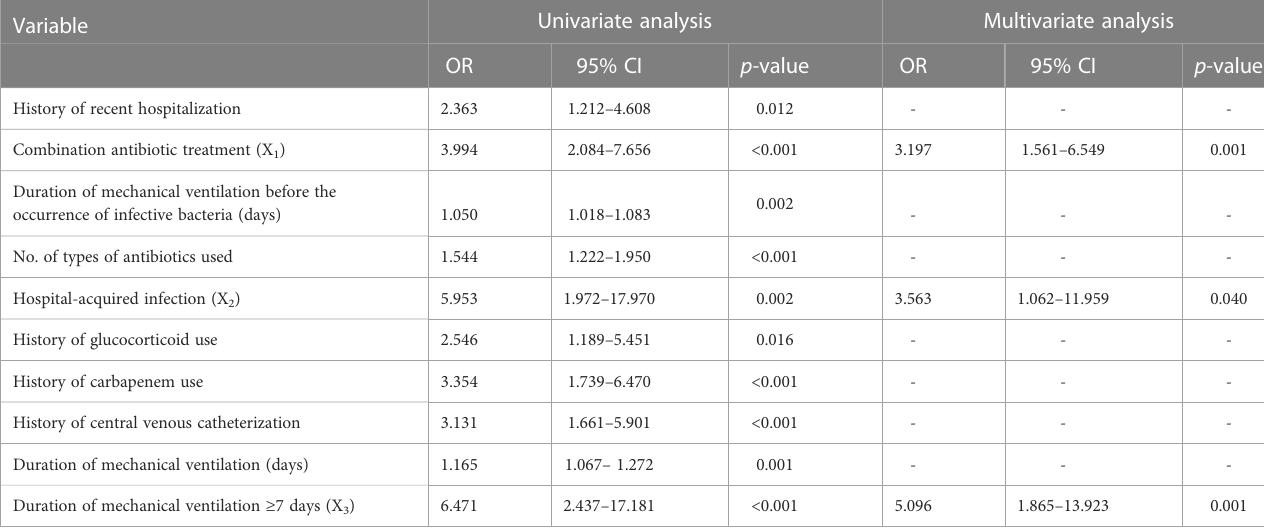
TABLE 5 Univariate and multivariate analysis for factors associated with CR-GNB infection in ICU patients. Variable